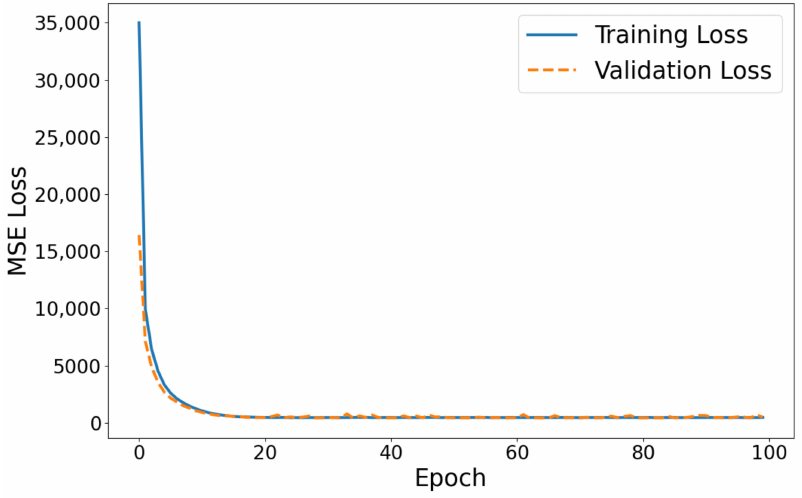
Figure 10. Training and validation losses during the throughout 100 epochs for